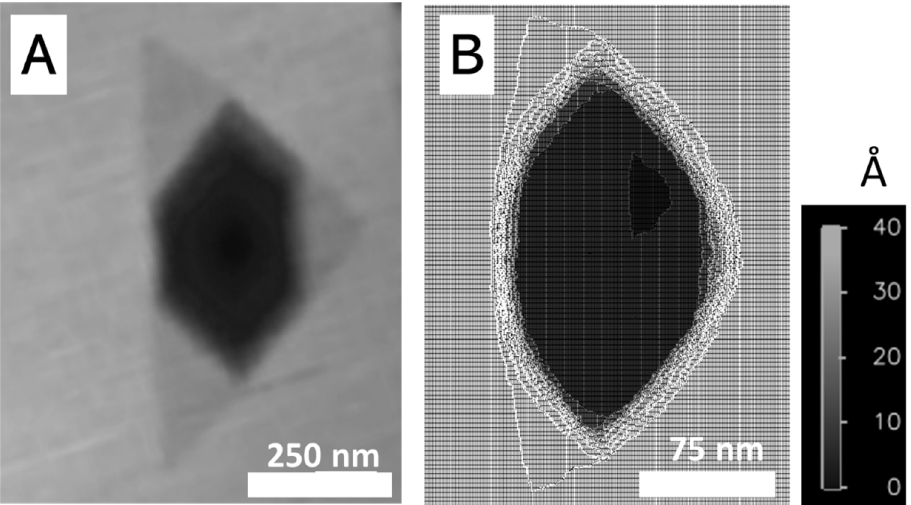
Figure 9. Morphology of multilayer pits on barite (001) face forming in pure water. ( A ): Experimental data [14] (Kuwahara, Y, In situ hot-stage AFM study of the dissolution of the barite (001) surface in water at 30–55 °C, (2012), Am. Min., 97, 1564–1573, Copyright (2012), MSA, reproduced with the permission of the Mineralogical Society of America); ( B ): KMC simulations (this work).